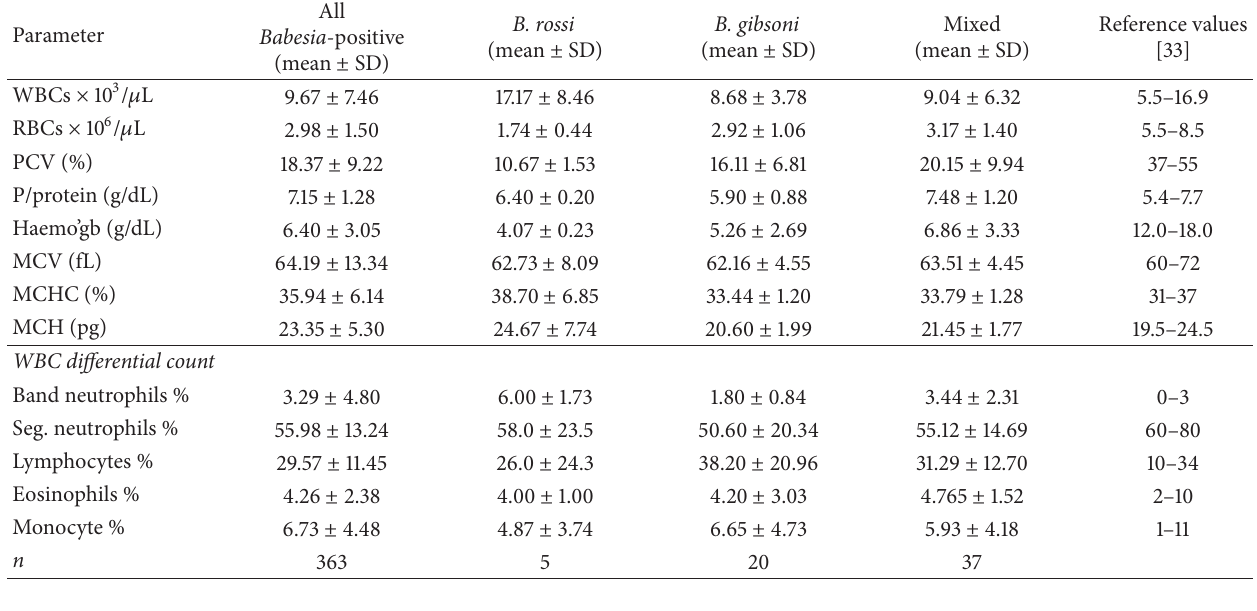
Table 2: Overall haematological findings in blood samples from Babesia -positive dogs ( 𝑛 = 363 ) and by species in Zambia. Parameter